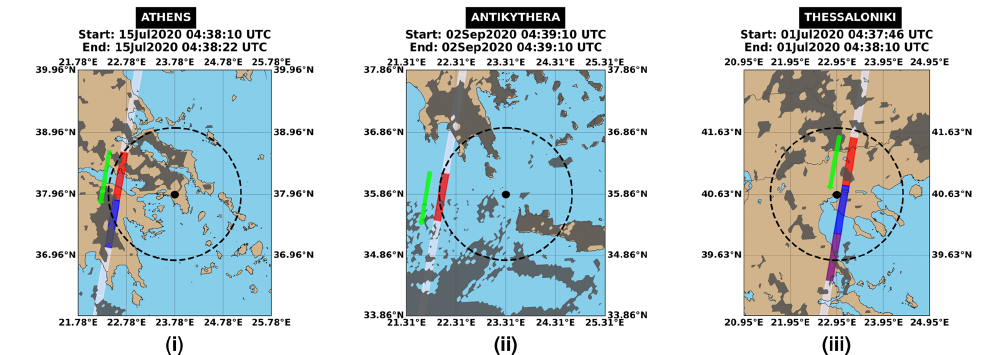
Figure 2. The white stripe indicates ALADIN’s measurement track, and the coloured rectangles correspond to the Aeolus observations ( ∼ 90km along-track-averaged measurements) falling within a radius of 120km (dashed black line) of the PANACEA stations (black dot). The green arrows show the Aeolus flight directions (descending orbits for these examples). Dark grey shaded areas show the MSG-SEVIRI cloud mask product (CLM) at the nearest time to the Aeolus overpass. The start and end times (in UTC) of the ALADIN observations are given in the title of each